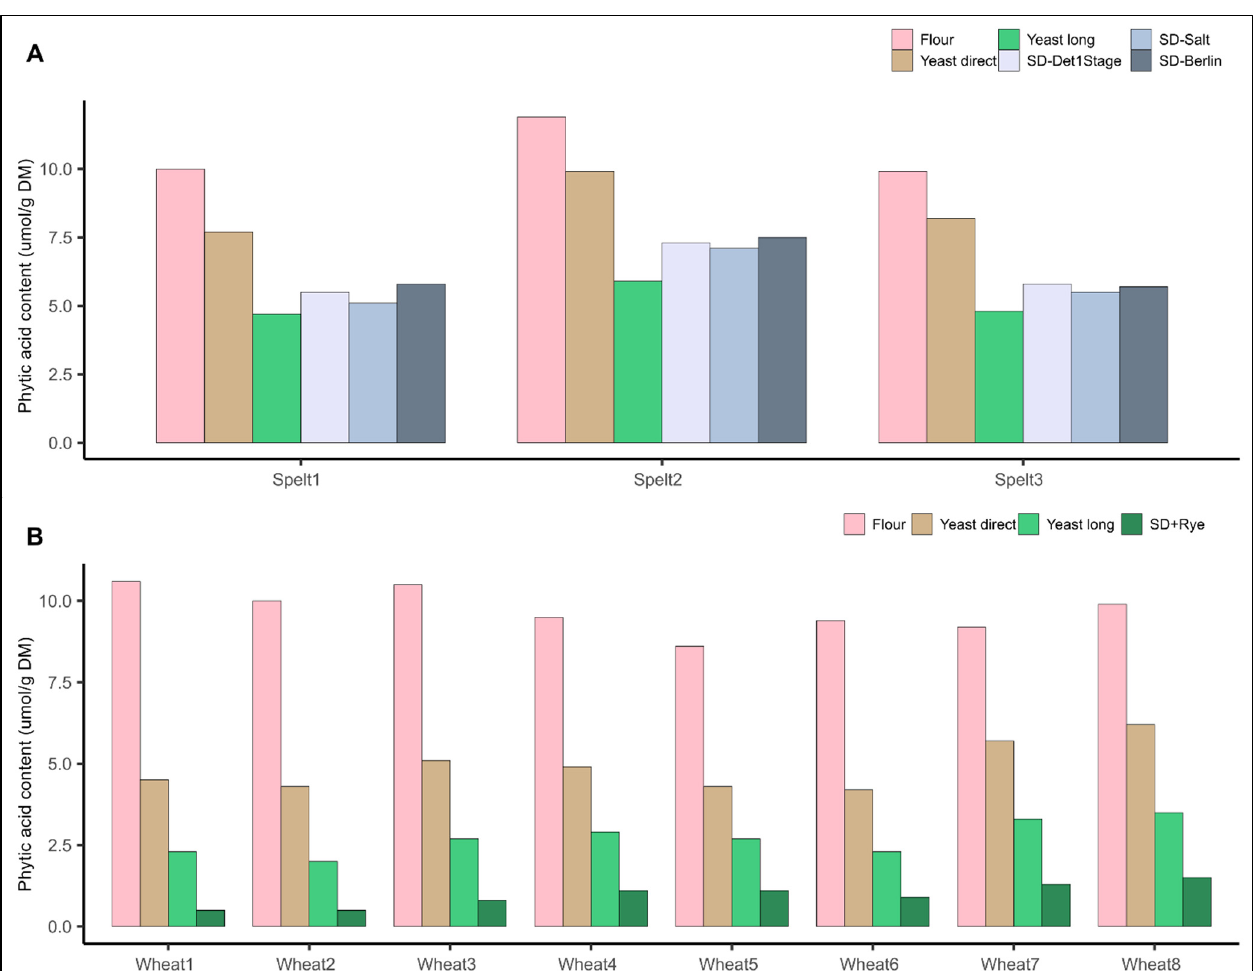
Figure 4. Phytic acid content in whole grain breads from three spelt varieties baked with five different recipes (( A ), trial series 3) and eight common wheat varieties baked with three different recipes (( B ), trial series 2). SD ‐ Det1Stage = Detmolder 1 stage sourdough, SD ‐ Salt = Monheim salty sourdough, SD ‐ Berlin = Berlin short sourdough, SD+rye = Detmolder 1 stage sourdough with standard rye flour.